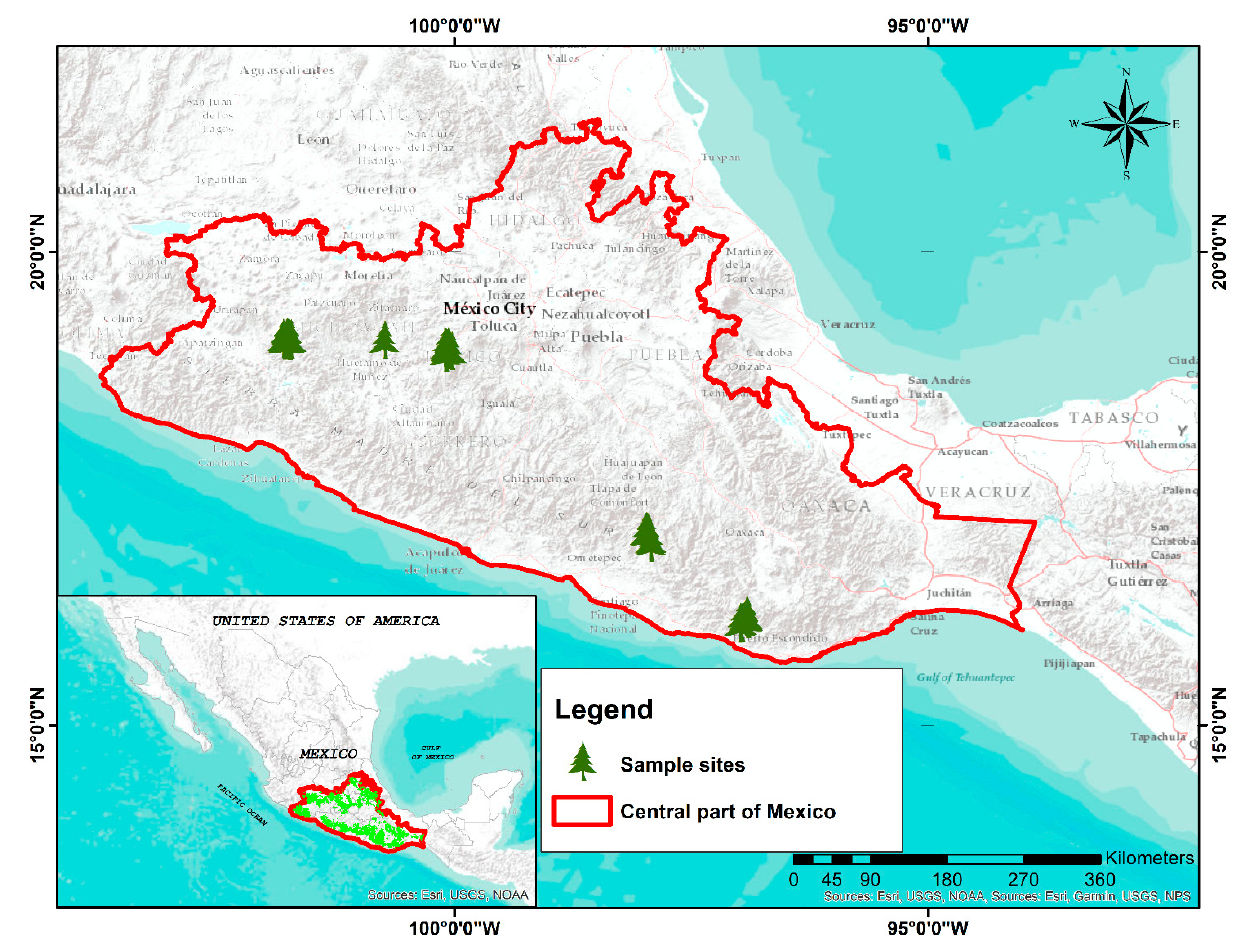
Figure 2. Spatial distribution of the Pinus oocarpa plus trees selected.